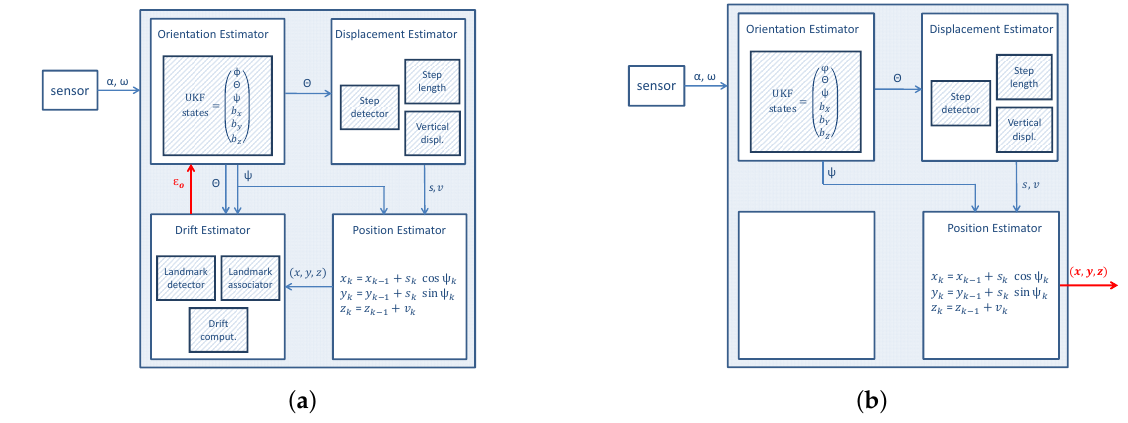
Figure 1. Proposed enhanced inertial pocket navigation system by including the landmark-based drift compensation algorithms in two steps: ( a ) first the drift value (cid:101) 0 is computed and ( b ) second this value is used by the orientation estimator to generate a drift compensated